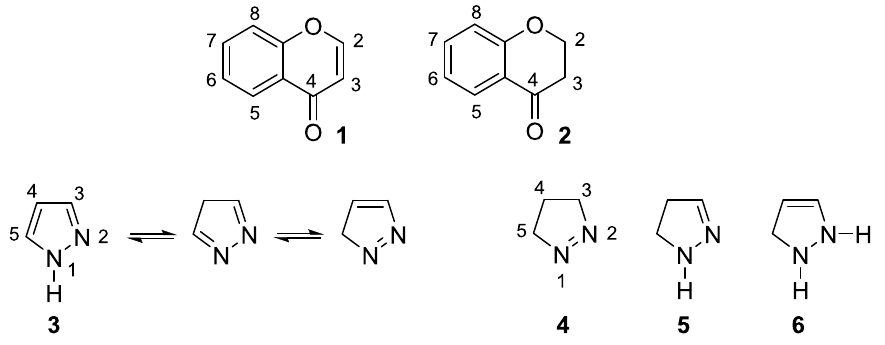
Figure 1. Chemical structures and numbering of compounds 1 – 6 .